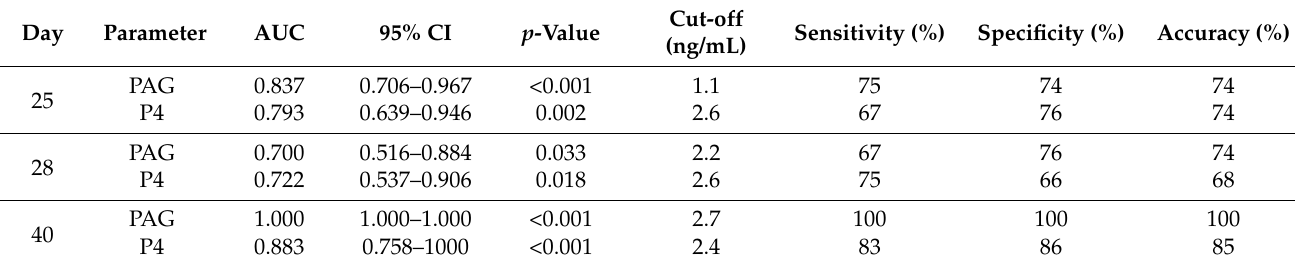
Table 2. Results of Receiver Operator Characteristic (ROC) analysis including the area under the ROC curve (AUC) with corresponding 95% confidence intervals (CI) and p -values, optimal cut-off with associated sensitivity, specificity and accuracy